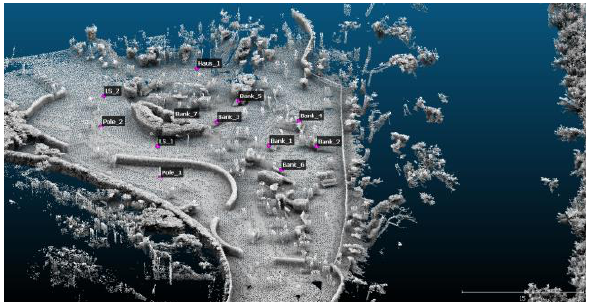
Figure 4. GCPs used to geo-reference the photogrammetric model based on the eye-tracking